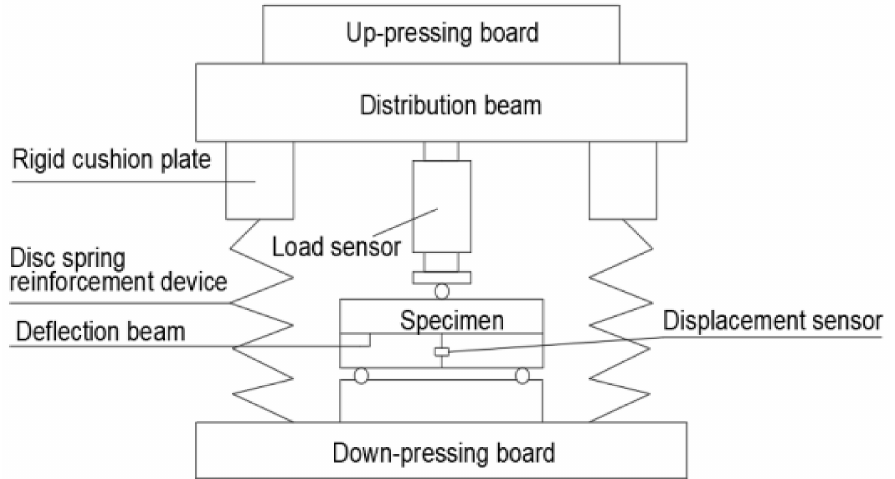
Figure 2. Sketch of the loading set-up for the three-point bending